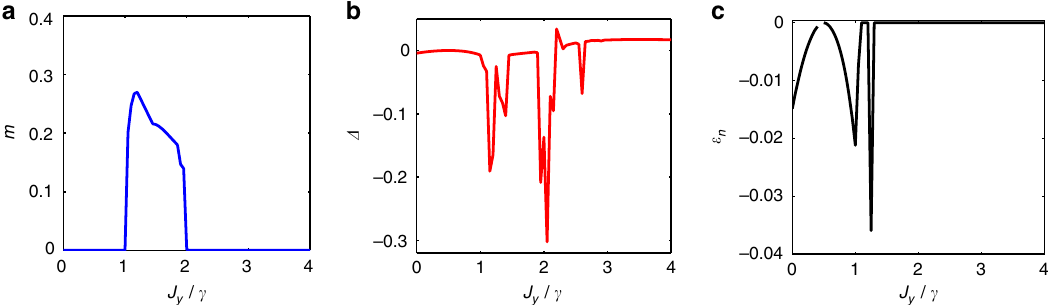
Fig. 4 Ferromagnetic order parameter and error measures. This is computed for the XYZ model, for J x = 0.5, J z = 1 and D = 4, with the order parameter as an average of M x j j ¼ σ x h ij j over the two sites a and b in our 2D PEPO construction of ρ , i.e., m (cid:5) M a x ferromagnetic order m at large values of J y / γ . In b , we show Δ (cid:5) # ρ plaquette. Larger errors as quanti fi ed by Δ and ε n appear around the phase transitions. Larger bond dimensions did not change the